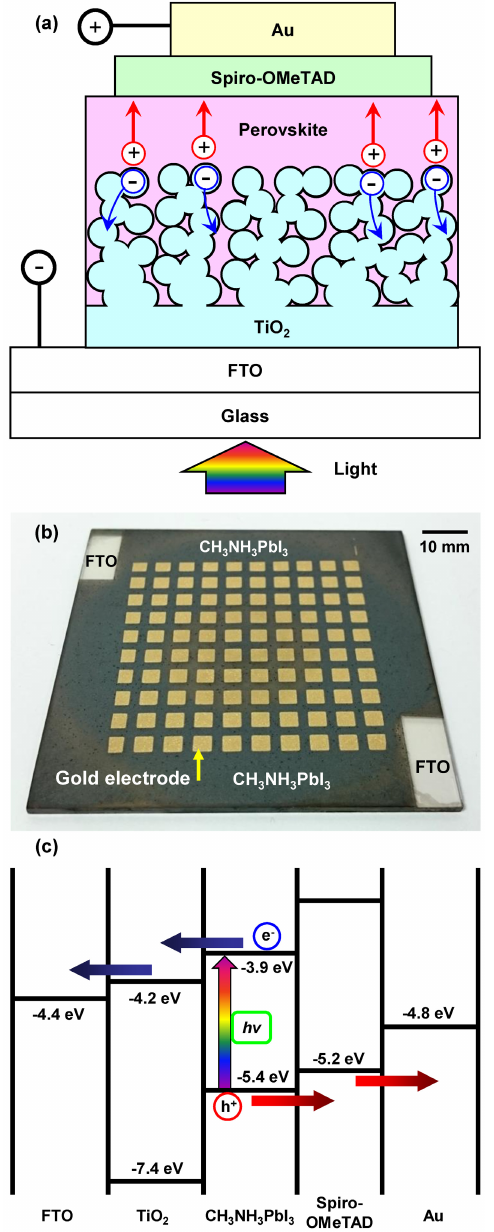
Figure 1: (a) Interfacial model of the perovskite solar cell. (b) Photo- graph of perovskite solar cell with the size of 70 mm × 70 mm. (c) Energy level diagram of the cell. Copyright (2014) The Japan Society of Applied Physics.